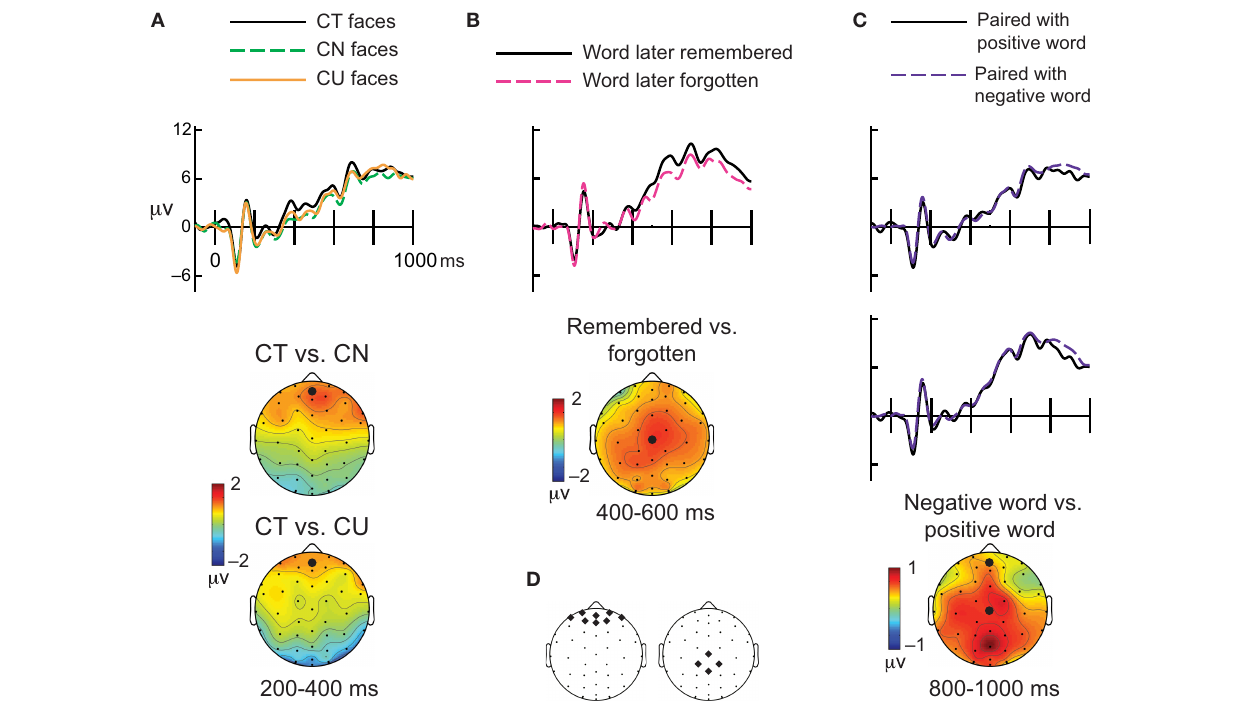
post-stimulus at central and parietal locations. ERPs are from the central midline location (Cz). (C) ERPs to faces differed as a function of previously paired word valence from about 800 ms post-stimulus. No differences were found in the frontal cluster. ERPs are from the anterior frontal midline and central midline locations (Fpz and Cz). (D) Frontal and central/parietal clusters used in statistical analyses are shown as large circles on schematic views of the